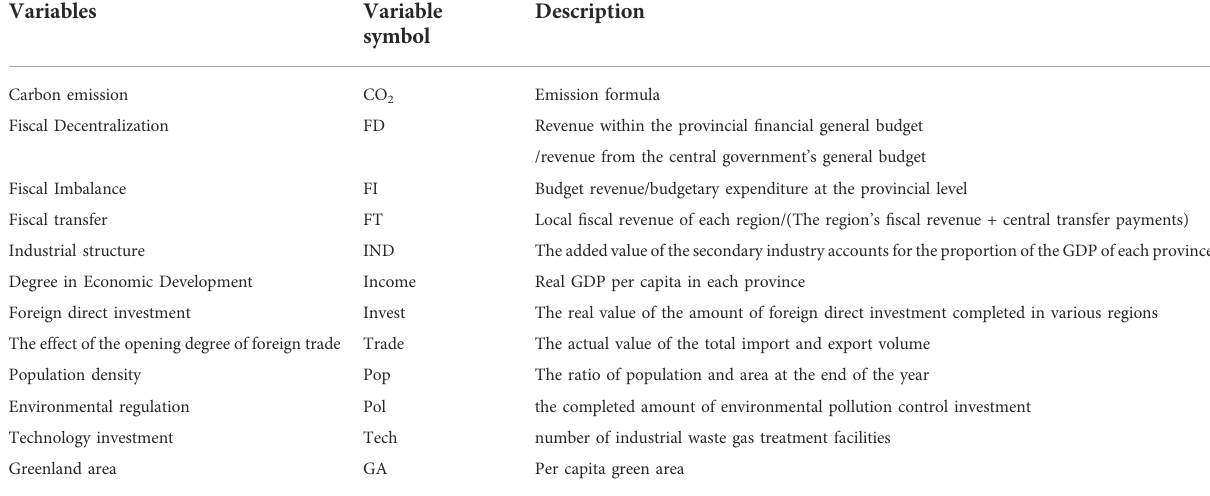
TABLE 1 The descriptive statistics of